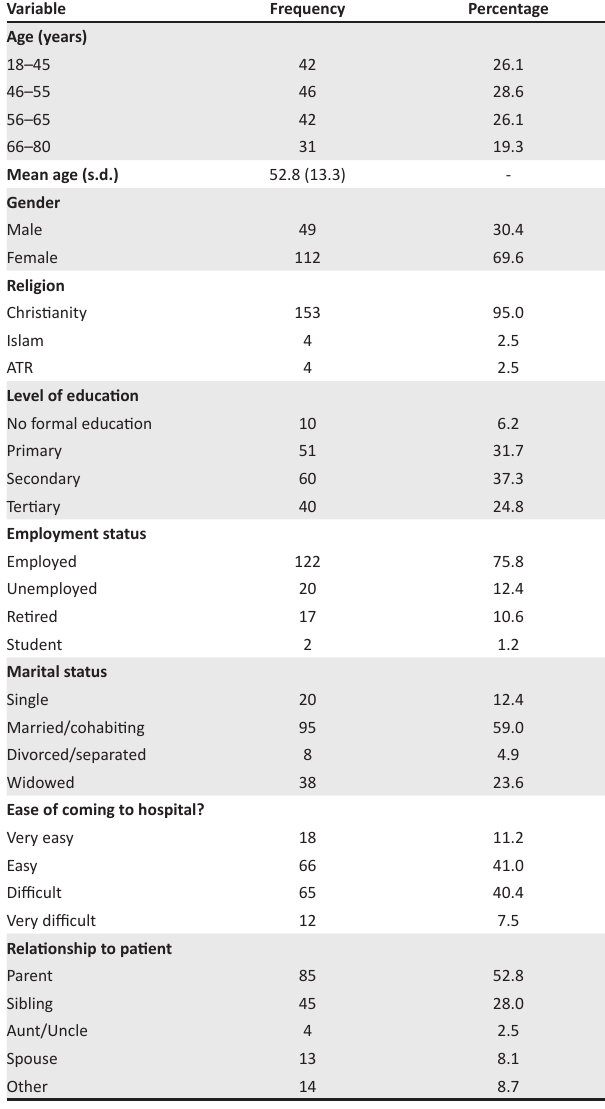
TABLE 2: Socio-demographic characteristics of